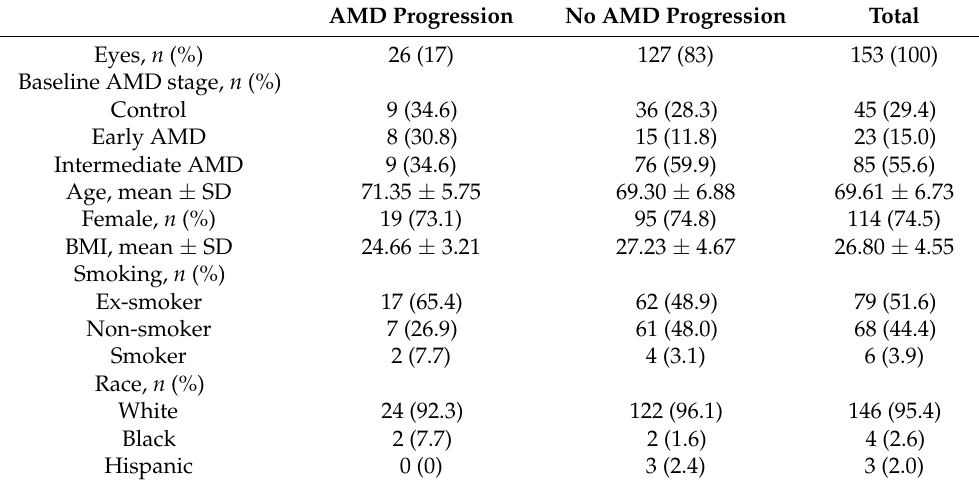
Table 1. Demographics of the included study